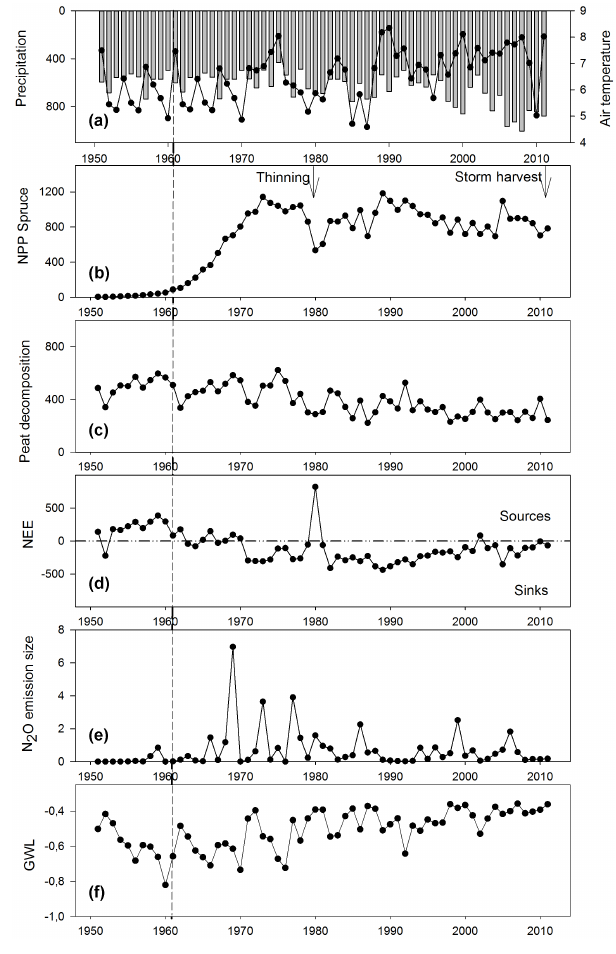
Figure 5. For the period 1951 to 2011: (a) annual precipi- tation (mmyr − 1 ) and air temperature ( 0 C); (b) the simulated annual NPP of spruce trees (gCm − 2 yr − 1 ) ; (c) simulated an- nual peat decomposition rate (gCm − 2 yr − 1 ) ; (d) simulated an- nual NEE (gCm − 2 yr − 1 ) ; (e) simulated annual N 2 O emissions (gNm − 2 yr − 1 ) ; (f) simulated annual GWL (m). The dashed ref- erence line separates the duplicated 1951 to 1961 and real climate 1961 to 2011. The source or sink is based on the atmospheric per- spective, e.g. the soil emissions are sources, and plant uptakes are sinks.